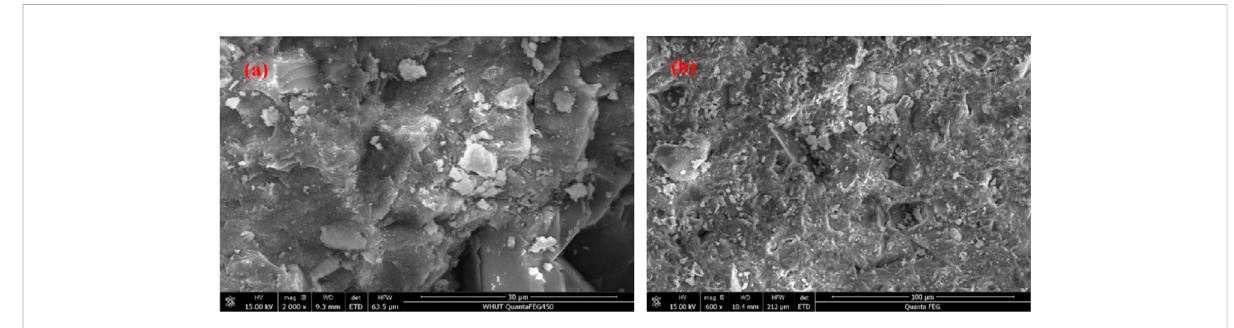
FIGURE 14 Microstructure of UHPC the dosage of BT=10%, (A) the surface of BT, (B) the microstructure of